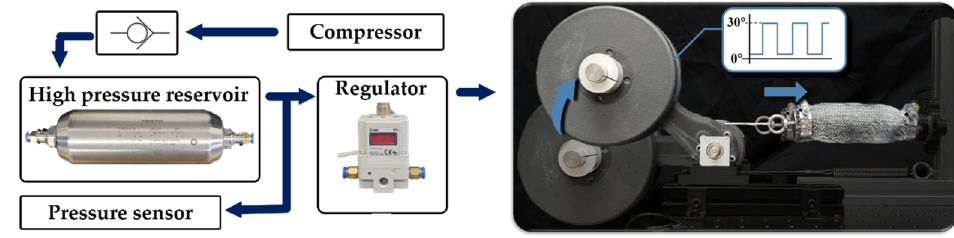
Figure 8. Schematic of air consumption evaluating testbed set.